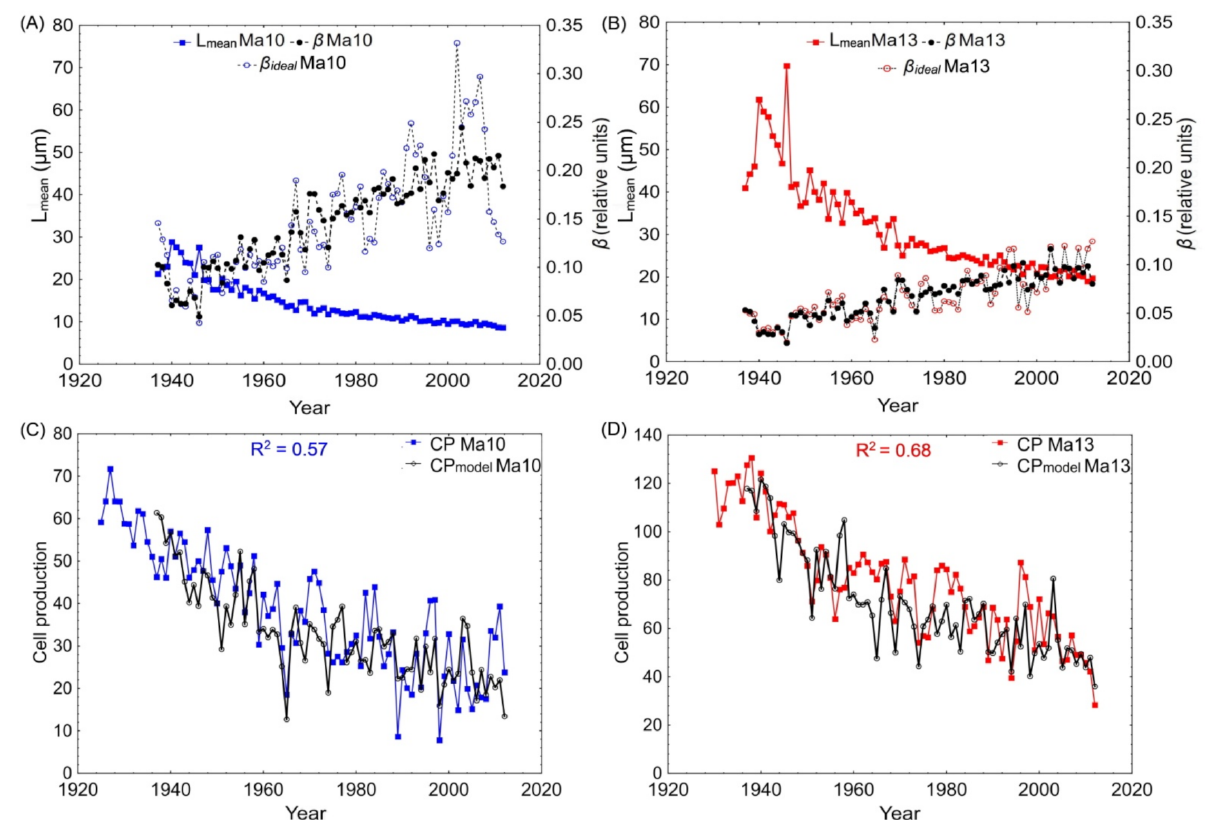
Figure 9. Variations of an average seasonal length of the cambium zone L mean (blue solid curve) and the specific growth rate of the cambial zone β (dashed curve) for Ma10 ( A ); variations of an average seasonal length of the cambium zone L mean (red solid curve) and the specific growth rate of the cambial zone β (dashed curve) for Ma13 ( B ); observed and simulated cell production for Ma10 ( C ) and Ma13 ( D ),